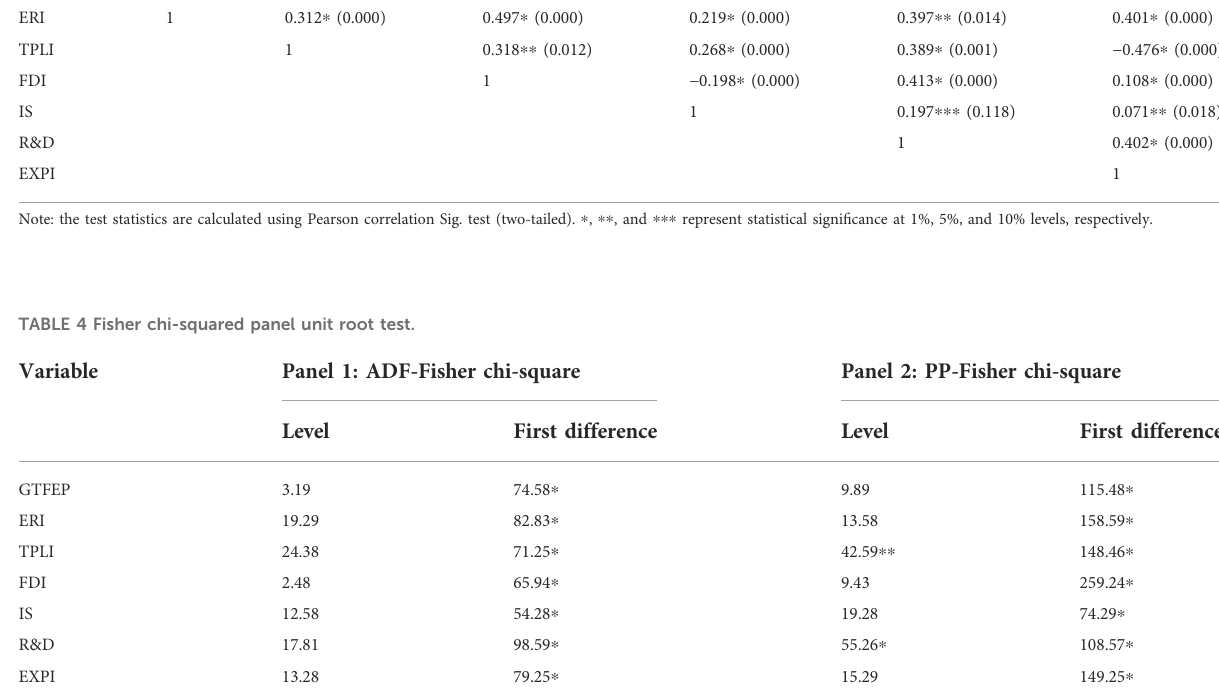
represented by Δ , and the long-run coef fi cients are represented by γ and γ . The lag length for the ARDL model , γ , γ , γ , γ , γ 1 2 3 4 5 6 7 is shown by m , whereas, the error term is represented by ε i,t .